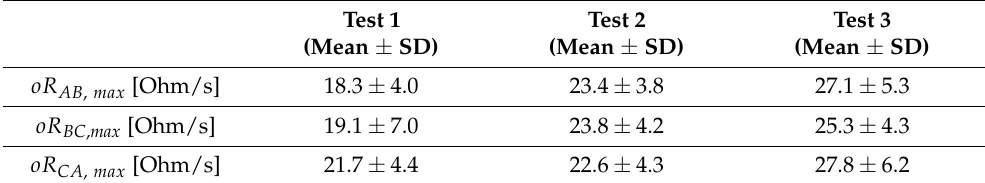
Table 3. For each pair of electrodes (AB, BC and CA), the maximum opening rate (oR _max ) is shown for the three working conditions (Test 1, Test 2, Test 3). Data are reported as mean values ± SD calculated over 16 cardiac cycles.